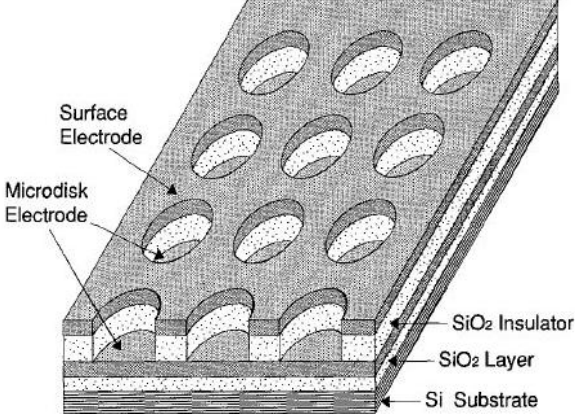
Figure 4. Microdisc array with vertically separated macroelectrode [42].